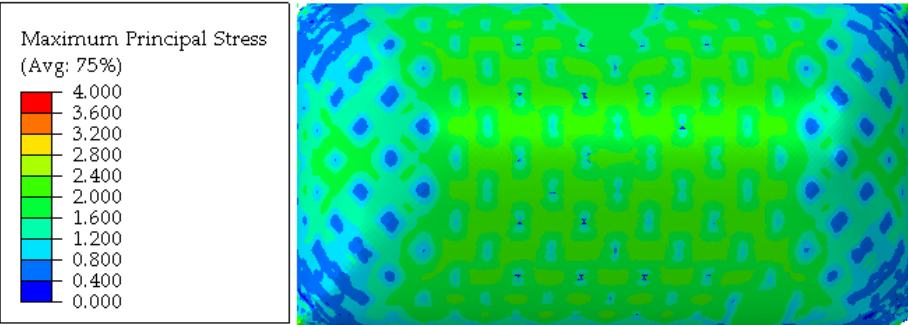
Figure 12. Stress of the membrane in fire conduction (MPa).